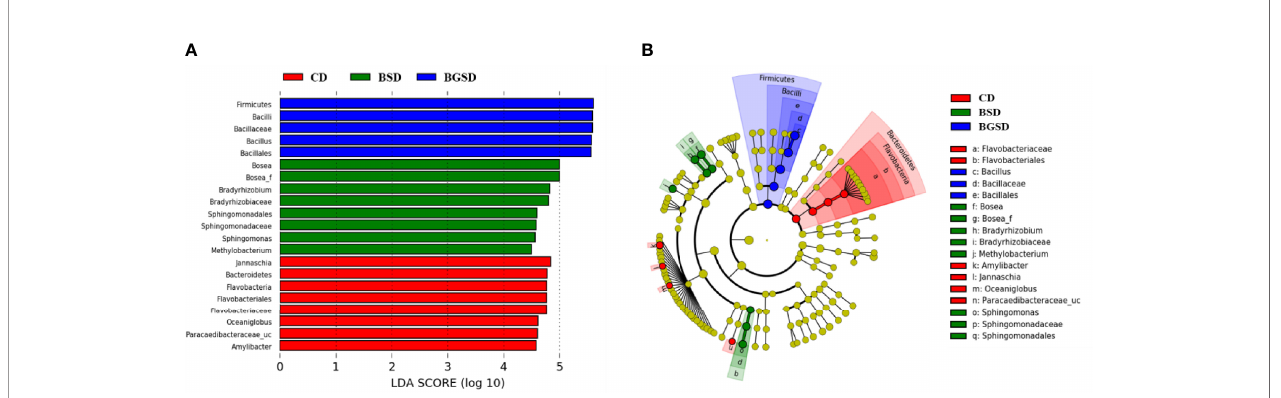
FIGURE 5 | Linear discriminant analysis effect size (LEfSe) analysis of the differential abundance of taxa within red sea bream intestinal microbiota following random sampling from each group. (A) Linear discriminant analysis (LDA) score of the abundance of different taxa; (B) cladogram showing differentially abundant taxa among the three groups from phylum to genus. Control diet, CD: without Bacillus sp. PM8313 or b -glucan, BSD: 1 × 10 8 CFU g − 1 Bacillus sp. PM8313, and BGSD: BSD + 0.1% b -glucan.